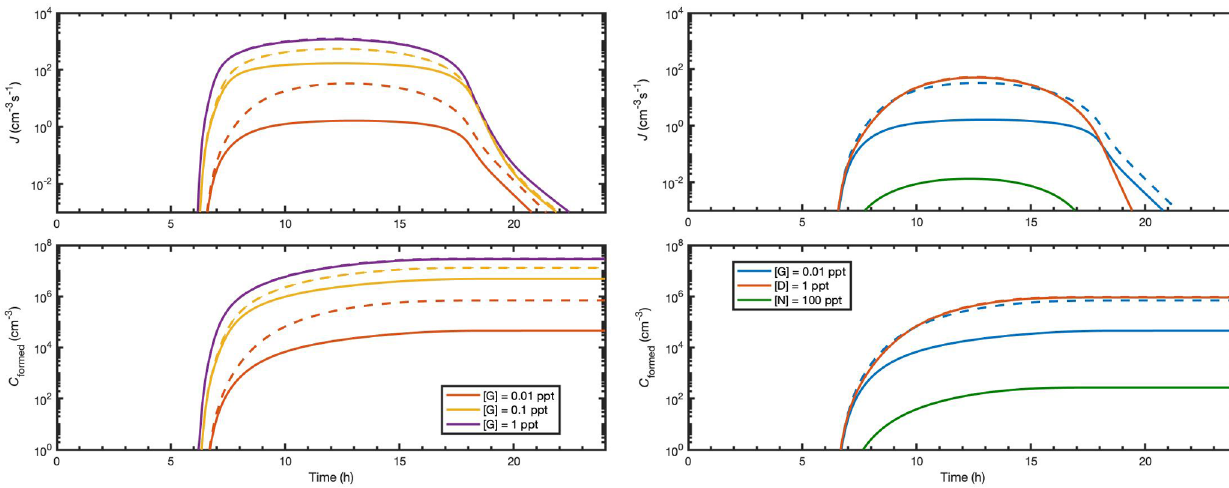
Figure 11. Particle formation rate J and concentration C formed of formed particles as a function of time when either the base source is constant (solid lines) or the base concentration is constant (dashed